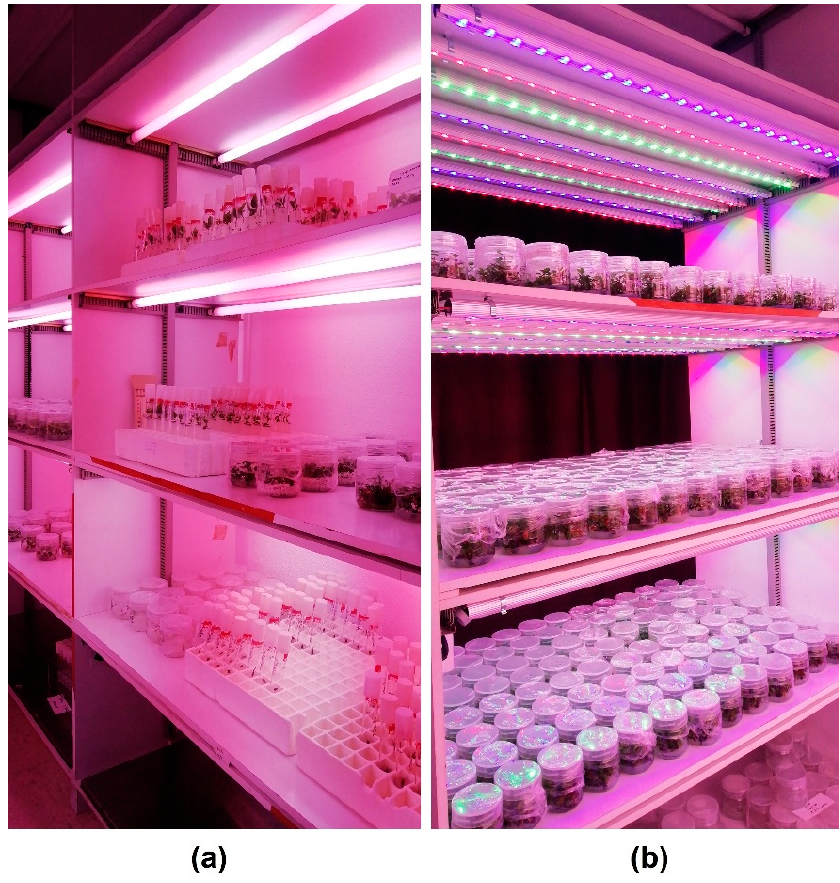
Figure 4. Test cabins with ( a ) Grolux fluorescent lamps and ( b ) LED Grolux spectrum equivalence.